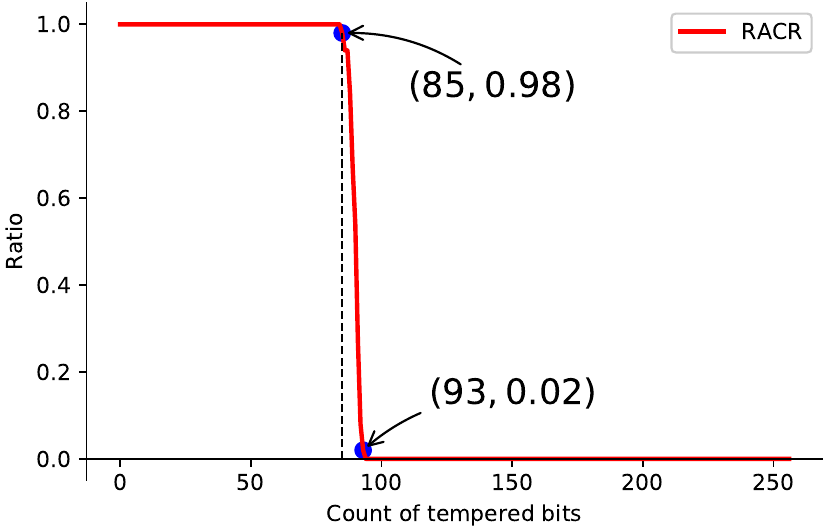
Figure 9. Recoverability of tampered